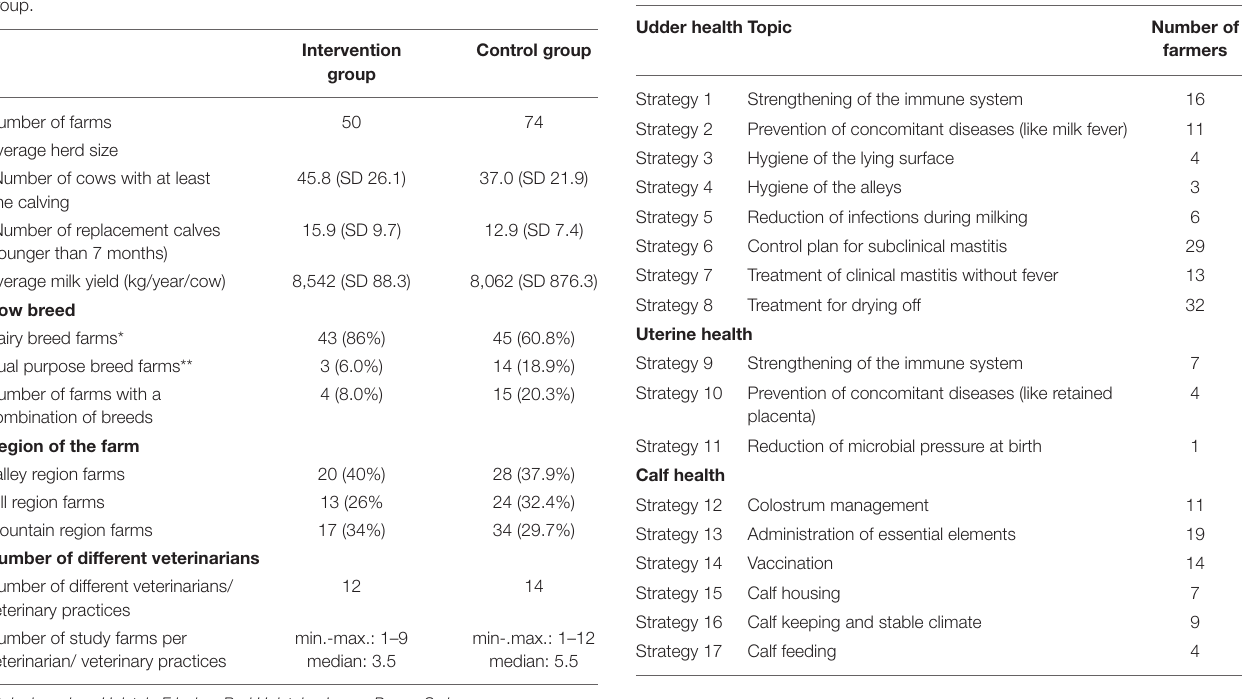
TABLE 2 | Number of farmers who chose a